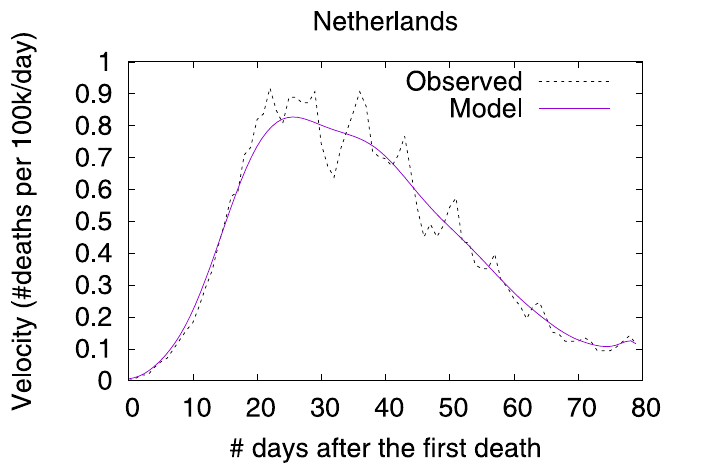
Fig 12. (Color online) projections for velocity in